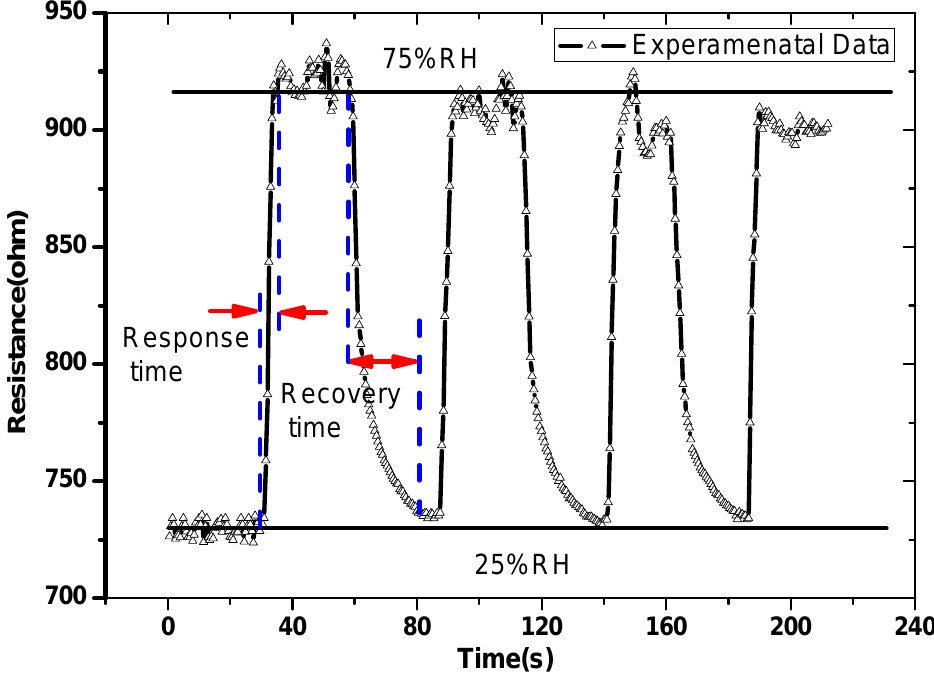
Figure 5. Time response and recovery curve of the MWCNT network from RH=25 % to 75 %.